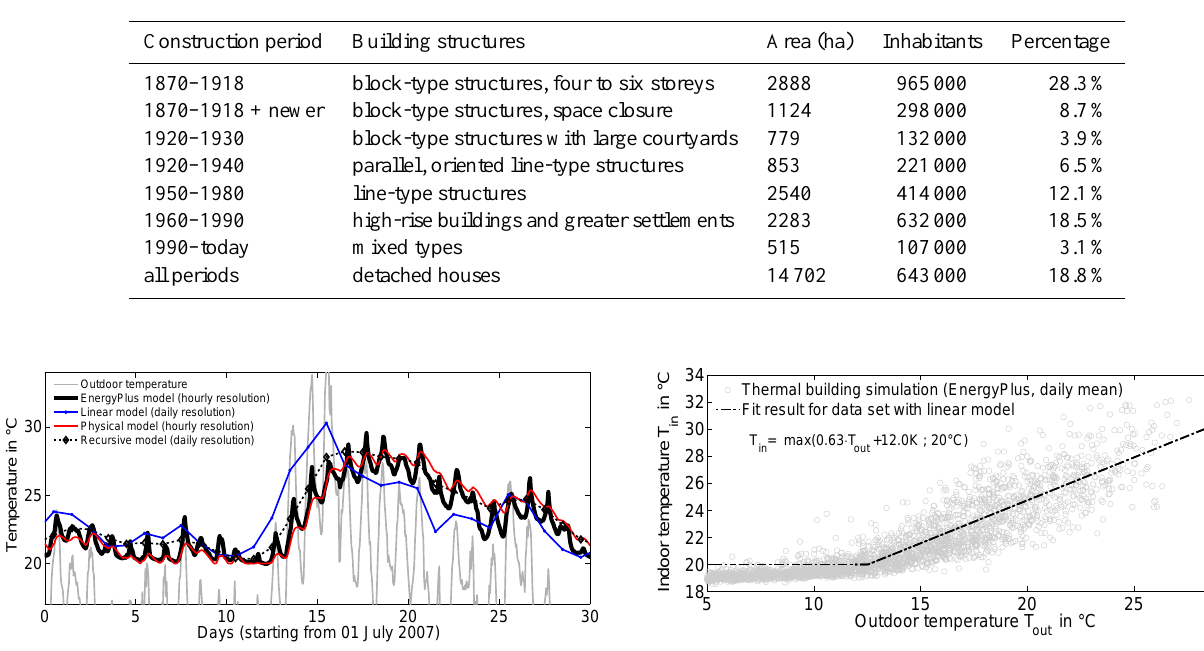
Figure 1. Typical residential building in Berlin (left) and graphical representation of the geometry of the EnergyPlus model (right). The analysis zone in the second floor is marked-up. Table 2. Building structures and construction periods in Berlin and number of inhabitants calculated with mean population density and area according to planning area typology (SDUD, 2011).